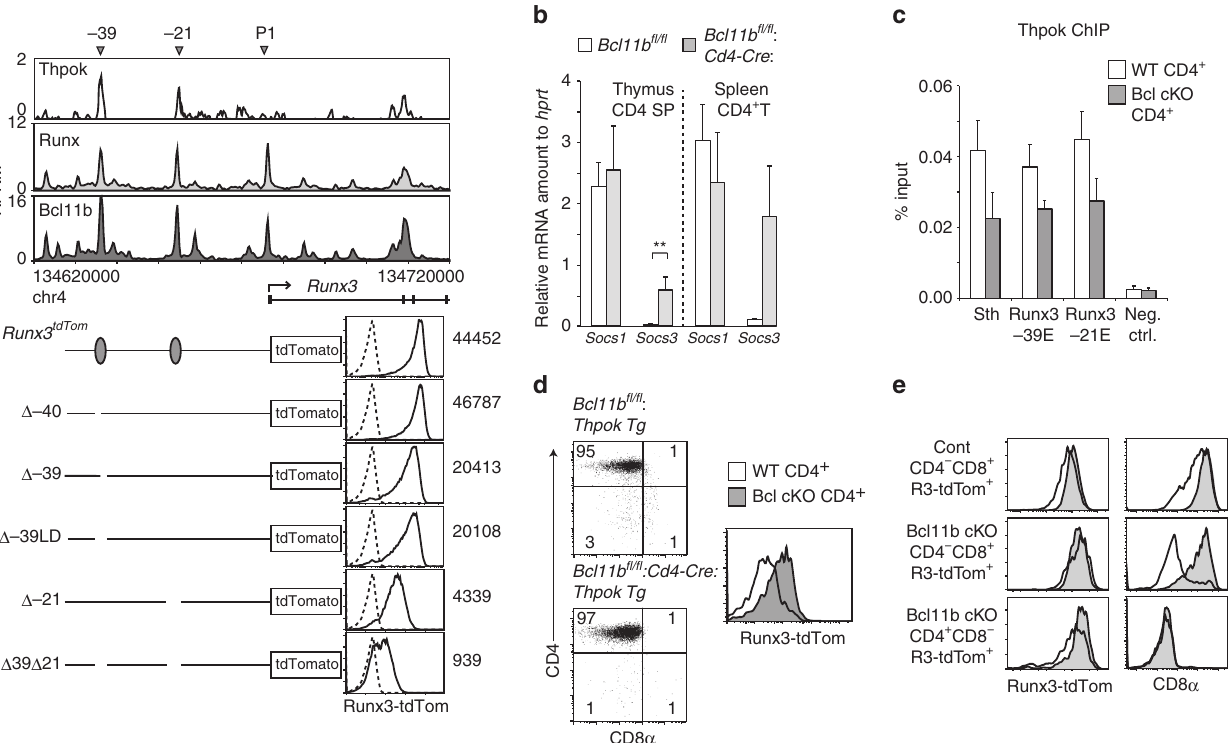
Fig. 5 Roles of Bcl11b in ThPOK-mediated repression of Runx3 . a Runx and Bcl11b ChIP-seq tracks at the Runx3 locus using total thymocytes, along with a ThPOK ChIP-chip track using CD4 SP thymocytes. Schematic structure of mutant Runx3 tdTomato reporter alleles harboring several types of deletion ( bottom panel , left ). Histograms ( bottom panel , right ) showing Runx3-tdTomato expression in CD4 − CD8 + thymocytes from indicated mutant alleles ( solid line ) and non-transgenic allele ( dotted line ). Data shown are representative of at least three independent mice. b Amount of Socs1 and Socs3 mRNA in CD4 SP thymocytes and CD4 + T cells from mice of indicated genotypes. Summary of three independent experiments. Mean ± SD ** P < 0.01 (unpaired t -test). c ChIP-qPCR analyzing ThPOK binding to the Sth in Thpok and the − 39E and − 21E regions in the Runx3 using chromatin from CD4 + T cells of Wt (white bars) and Bcl11b f/f :Cd4-Cre (gray bars) mice. Combined data of three independent ChIP experiments. Means ± SD. d Flow cytometry analyzing the effect of a Thpok transgene on Cd8 and Runx3 expression. Dot plots showing CD4/CD8 expression in splenic T cells. Histograms at the right show Runx3 tdTomato reporter expression in Wt (white) and Bcl11b-de fi cient (gray) CD4 + CD8 − subset. One representative of three individual mice. e Histograms showing CD8 and Runx3-tdTomato expression in control CD4 − CD8 + , Bcl11b-de fi cient CD4 − CD8 + and CD4 + CD8 − T cells after retroviral transduction of Wt ( open ) and the non-functional HD mutant ThPOK ( shaded ). One representative of two independent